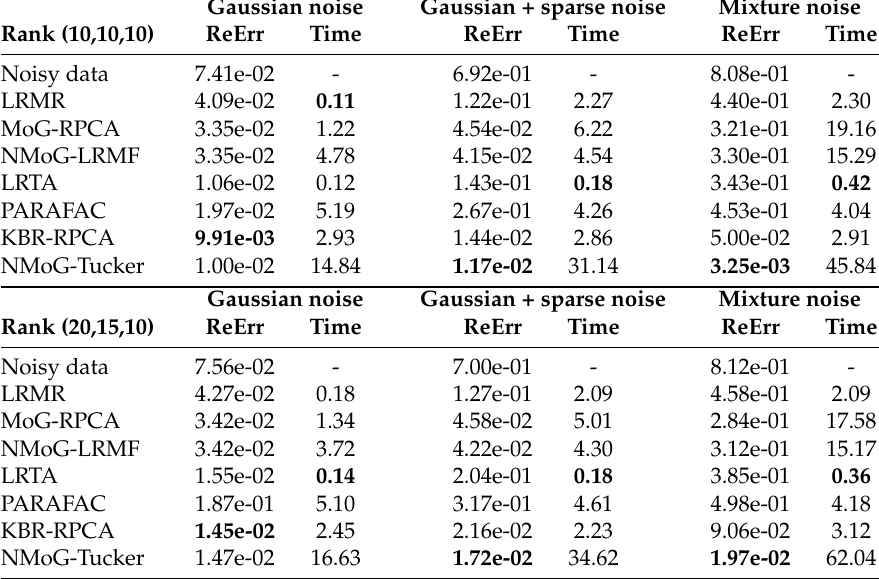
Table 2. Quantitative performance and execution time (in seconds) of different methods on synthetic data denoising. Every result is an average over ten trials with different realizations of both data and noise. The best results are highlighted in